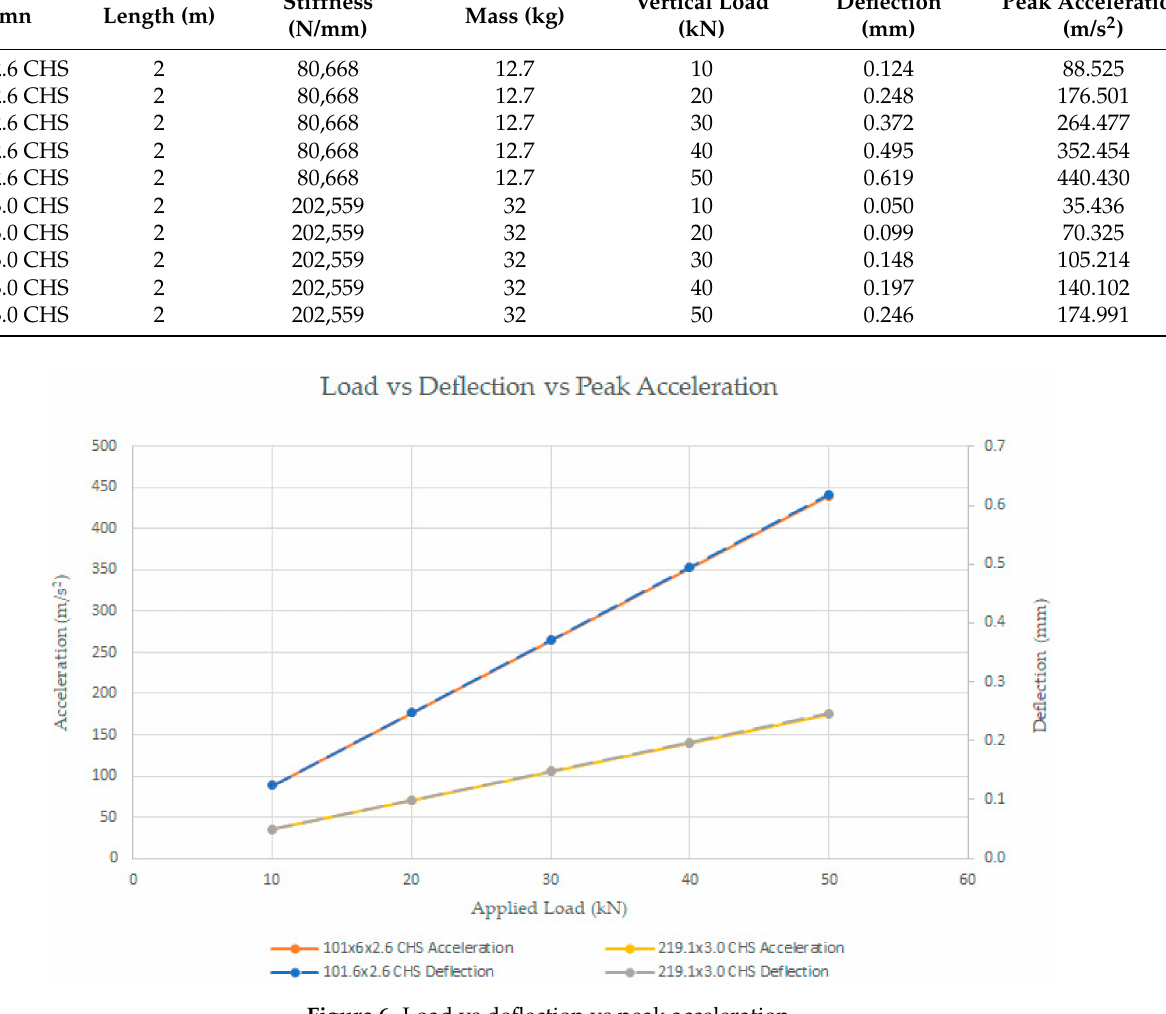
Figure 6. Load vs deflection vs peak